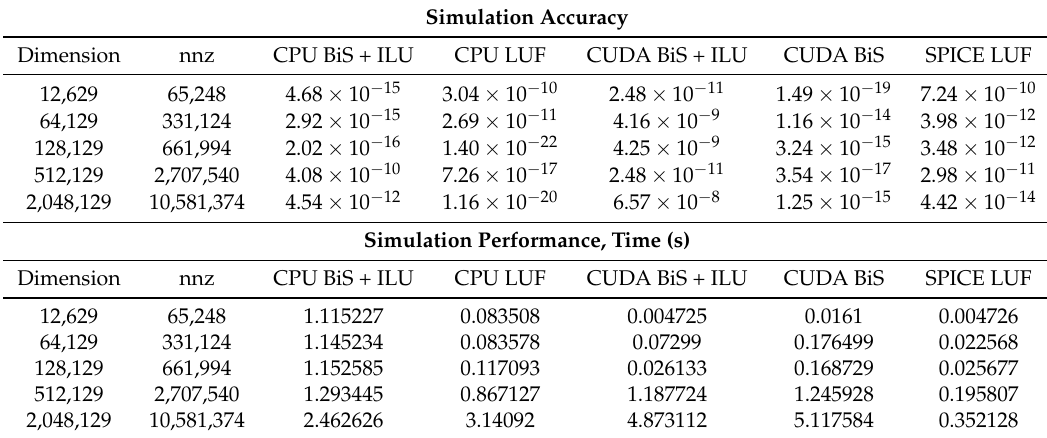
Table 2. Comparison of performance and reliability of the result of individual algorithms for different sizes of simulation matrix.